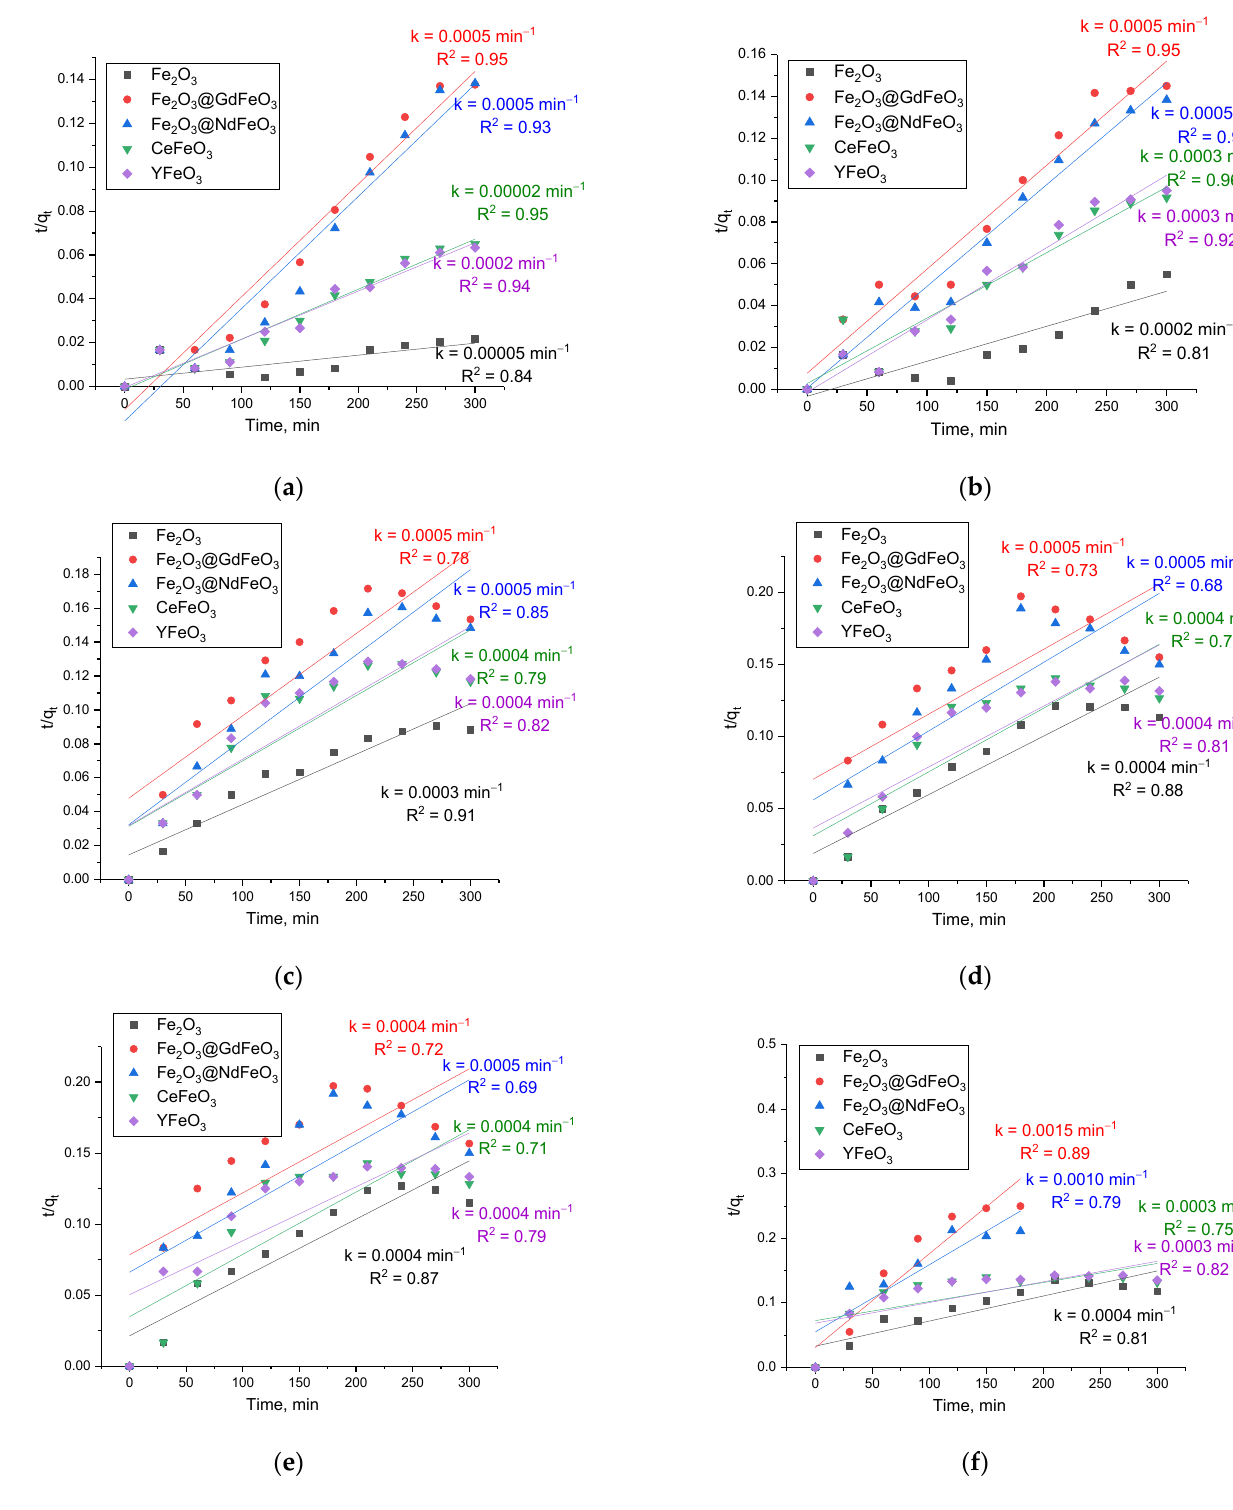
Figure 8. Results of constructing pseudo-second-order kinetic curves of the adsorption reaction to determine the rate constant of the reaction of the studied nanoparticles with a change in their mass in solution: ( a ) 0.01 g; ( b ) 0.05 g; ( c ) 0.10 g; ( d ) 0.25 g; ( e ) 0.50 g; ( f ) 1.00 g. Table 1 presents the results of the estimated parameters of the kinetic models used to evaluate the obtained results of manganese adsorption using various nanocomposites.